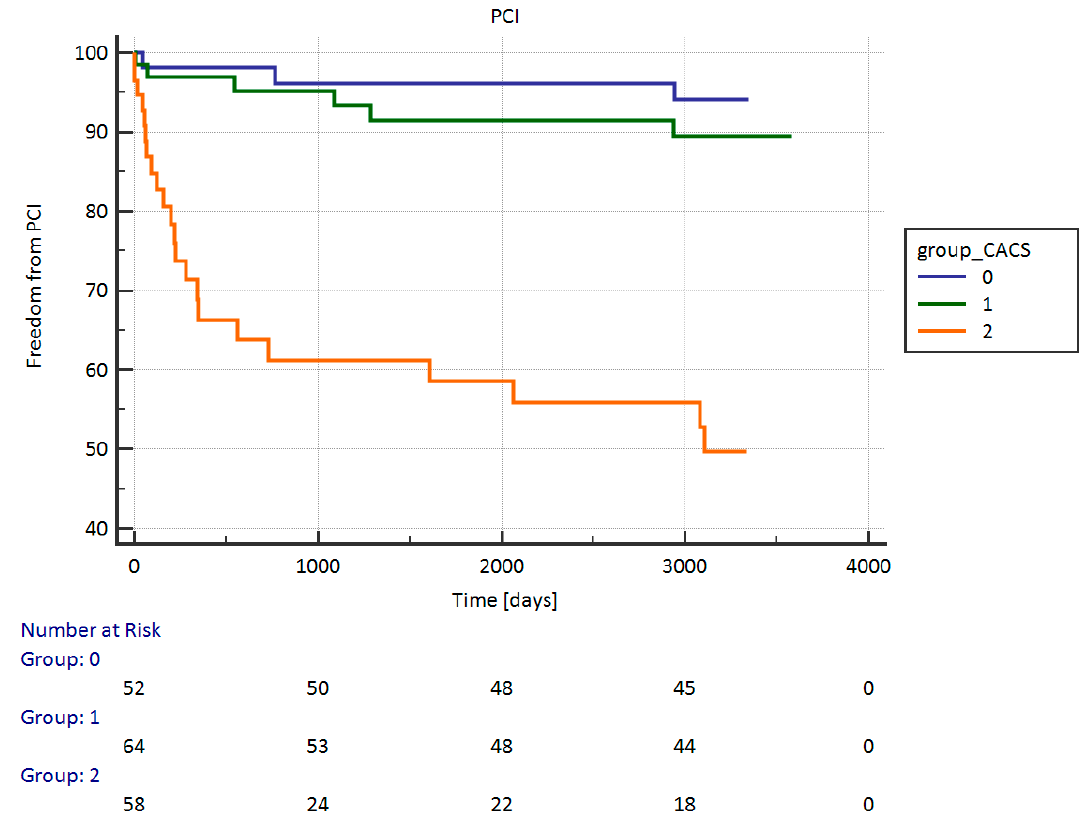
Figure 4. Event-free from PCI survival between patients with groups according to the CACS results. PCI: percutaneous coronary intervention.